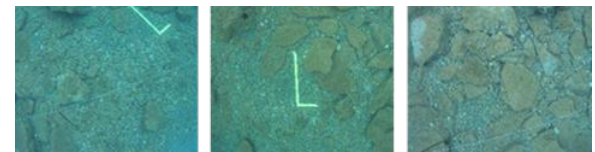
Figure 3. Sample of data set of Andrina’s seabed